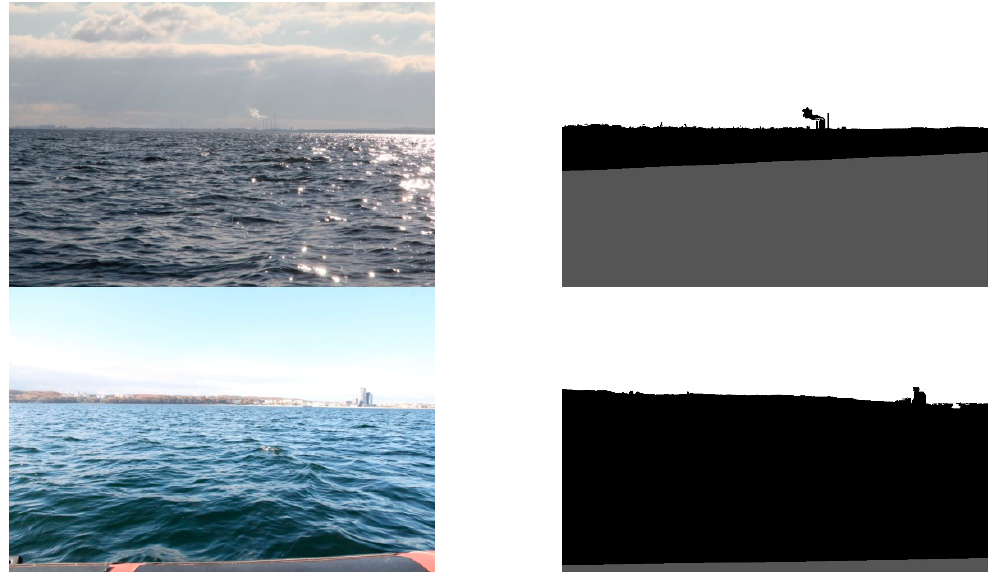
Figure 12. Results of incorrectly detected shorelines.